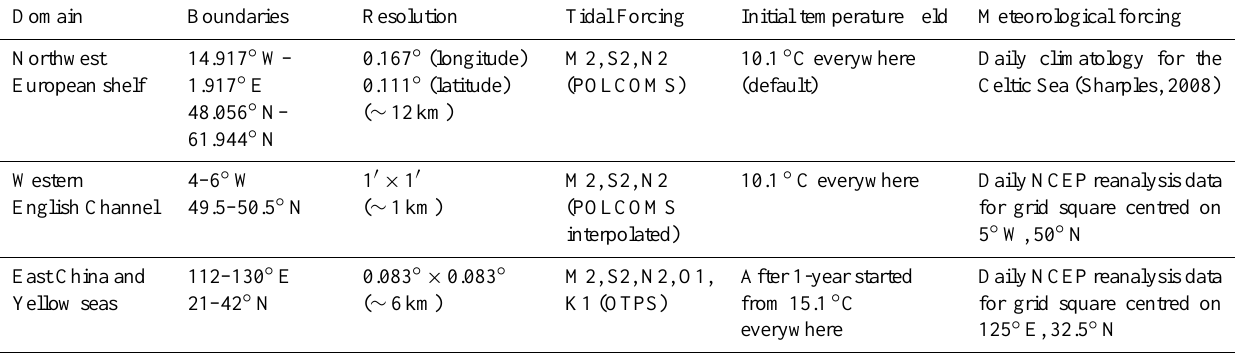
Table 1. Boundaries, resolution, tidal forcing, initial temperature and meteorological forcing for each domain (POLCOMS is Proudman Oceanographic Laboratory Coastal Ocean Modelling System; OTPS is OSU Tidal Prediction